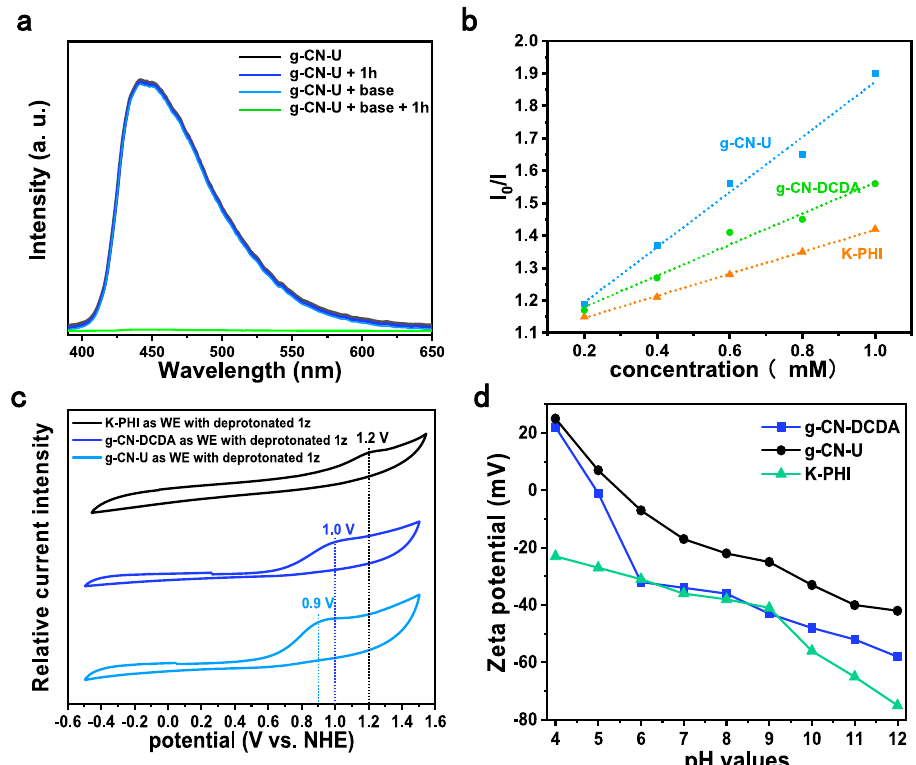
Fig. 4 | Surface property studies. a Steady-state photoluminescence spectra of g- CN-U, g-CN-U/substrate, g-CN-U/base, and g-CN-U/substrate/base in CHCl 3 ( λ exc = 390nm). b Stern-Volmer analysis of the steady-state emission intensity at 450nm ( λ exc =390nm) with varied substrate concentration. c CVs obtained in a 0.1M